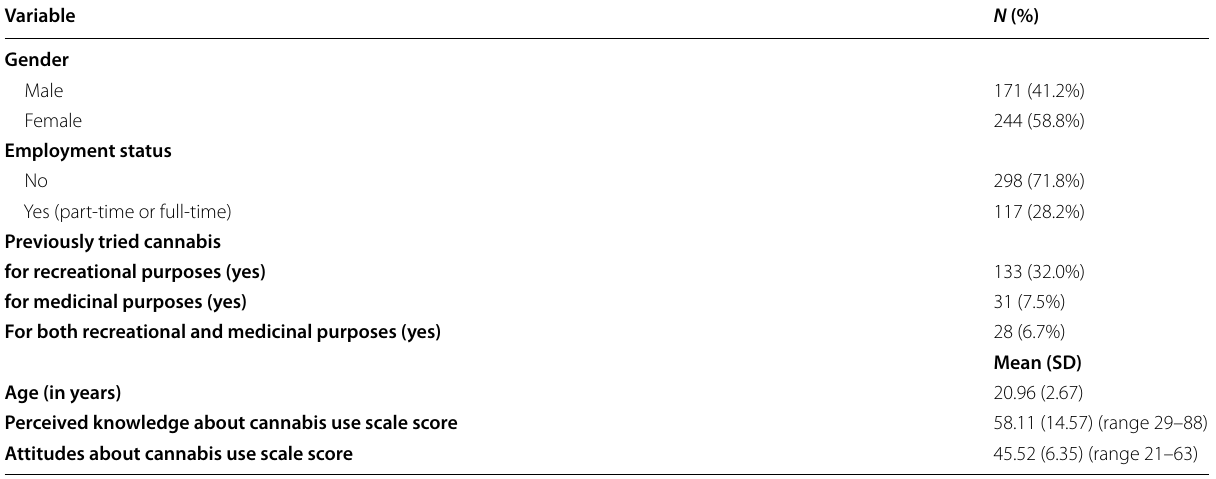
Perceived knowledge is the participant accumulated information on cannabis use and its effects. Attitude is the individual’s thoughts and opinion on cannabis recreational and medical use. Both metrics were obtained from the respective scales created Perceived knowledge about cannabis use scale score [min: 29, max: